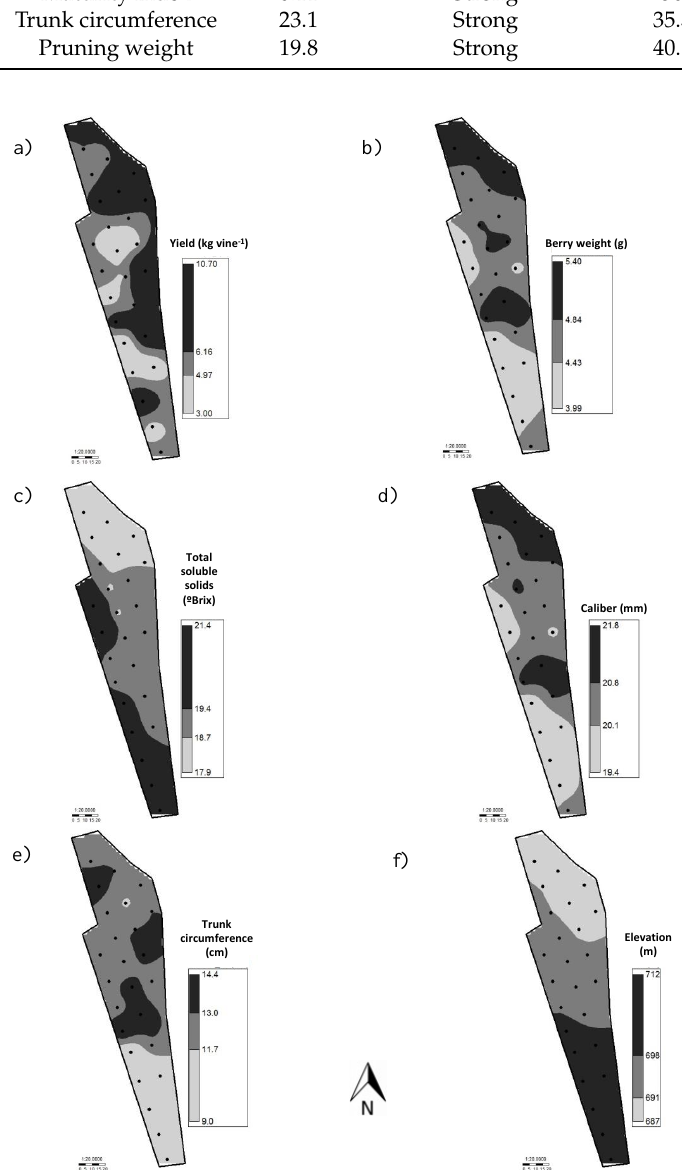
Figure 3. Maps of the main variables determined in table grapes cultivated in the slope plot. ( a ) Yield, ( b ), berry weight, ( c ) total soluble solids, ( d ) caliber, ( e ) trunk circumference, ( f ) elevation.